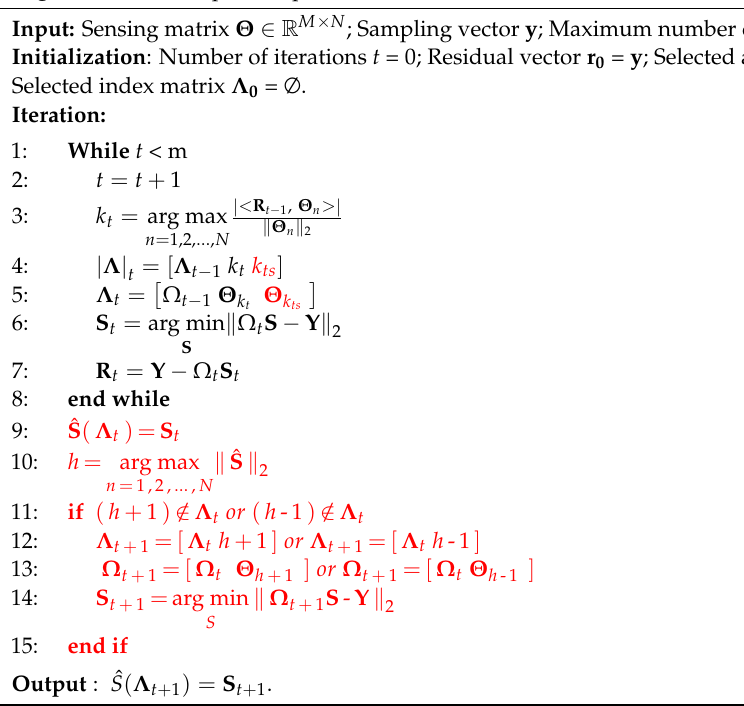
Algorithm 1 The steps of improved